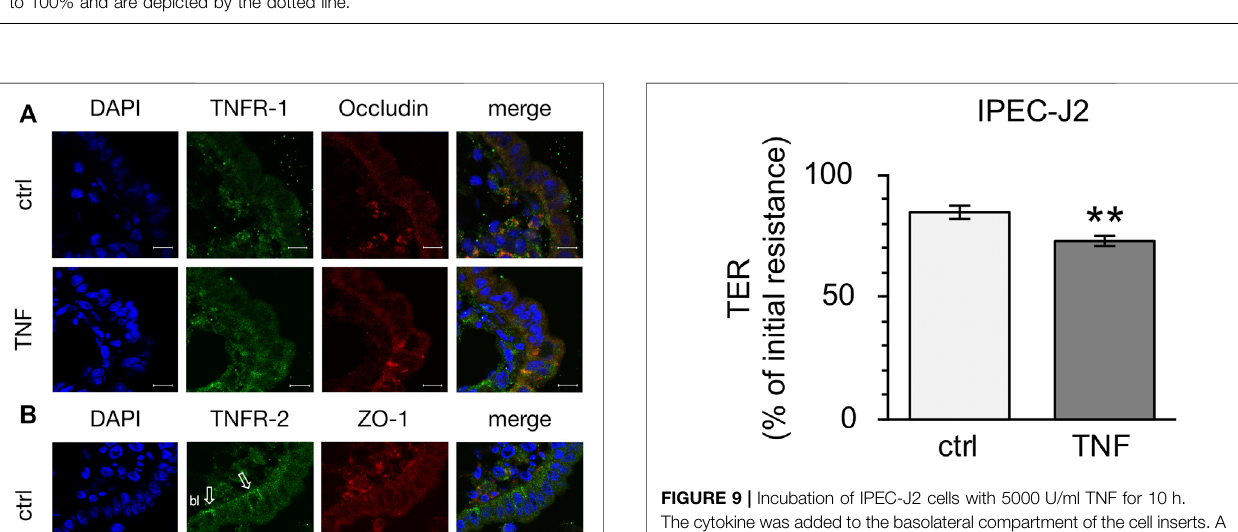
Frontiers in Physiology |